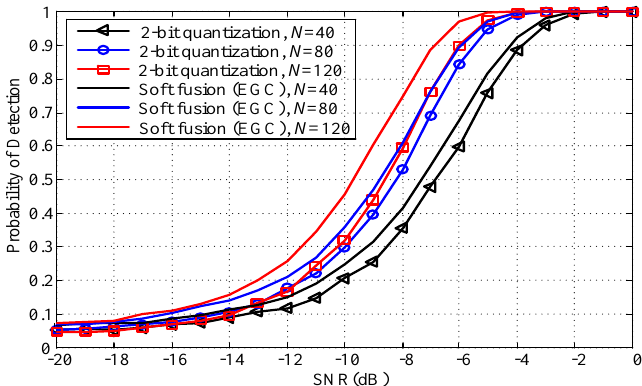
Figure 7. Probability of detection versus SNR for different values of N ( M = 4, Q f = 0.05).